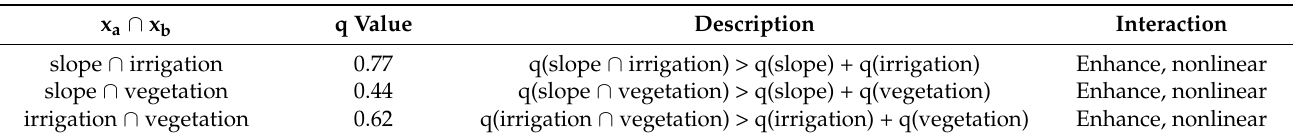
Table 3. Interaction effects of dominant factors on poverty